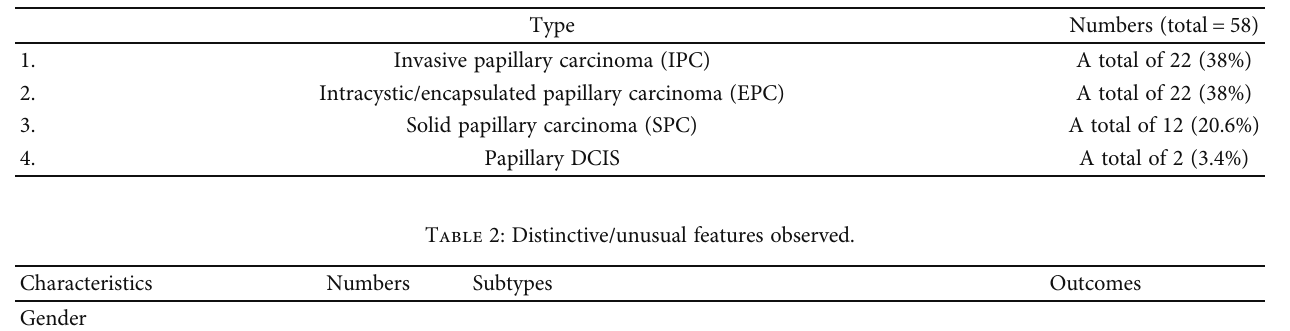
Table 1: Types of papillary carcinoma in study.